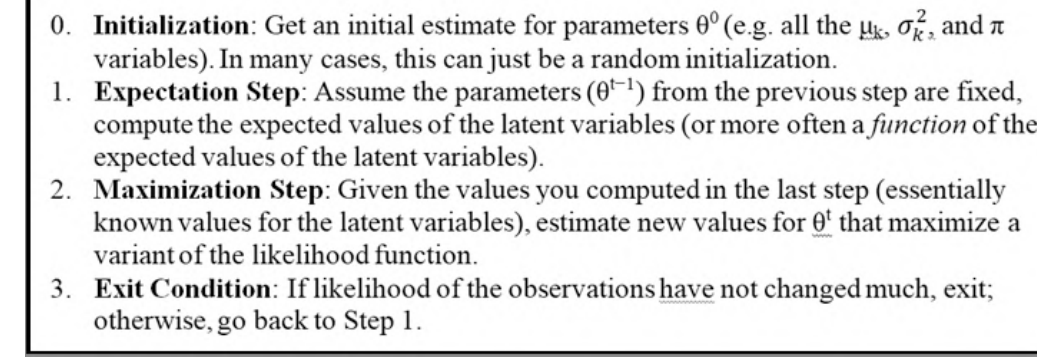
Figure 2: Presentation of paper